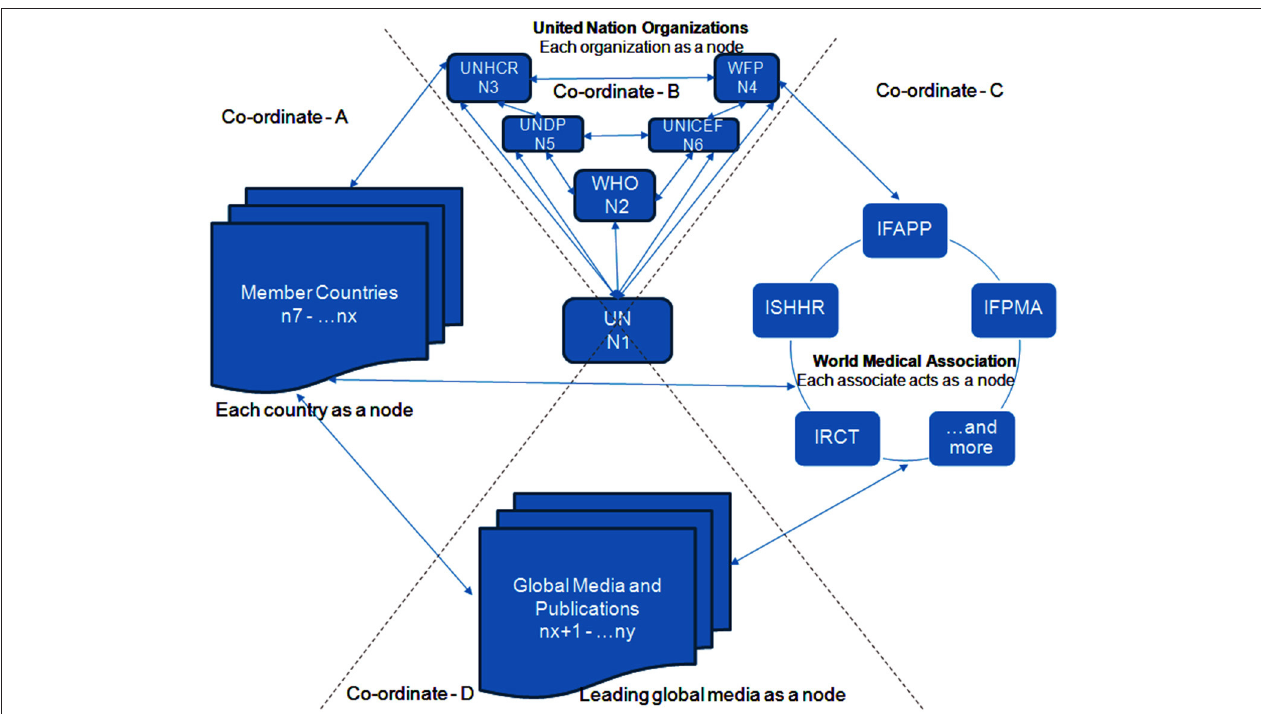
FIGURE 1 | The actors involved in blockchain are nodes (N) [a distributed network such as United Nations organizations (UNO), participant countries, global medical associations, media, and publications, which participate in sharing information], chain code (rules and regulations to be agreed upon by nodes before validation), and global ledger (execution platform of a transaction to share an immutable and updated information with the agreement of at least 51% of the nodes in the form of decentralized and distributed database to bring trust and transparency in the system). ABCD, simplified into quadrants based on node’s area of functionality; UNHCR, The United Nations High Commissioner for Refugees; UNDP, The United Nations Development Programme; UNICEF, The United Nations Children’s Fund; WHO, The World Health Organization; IFAPP, International Federation of Associations of Pharmaceutical Physicians; ISHHR, International Society for Health and Human Rights, IRCT, International Rehabilitation Council for Torture Victims; IHF, International Hospital Federation; IFPMA, International Federation of Pharmaceutical Manufacturers and